Question: Write a descriptive caption for this figure.
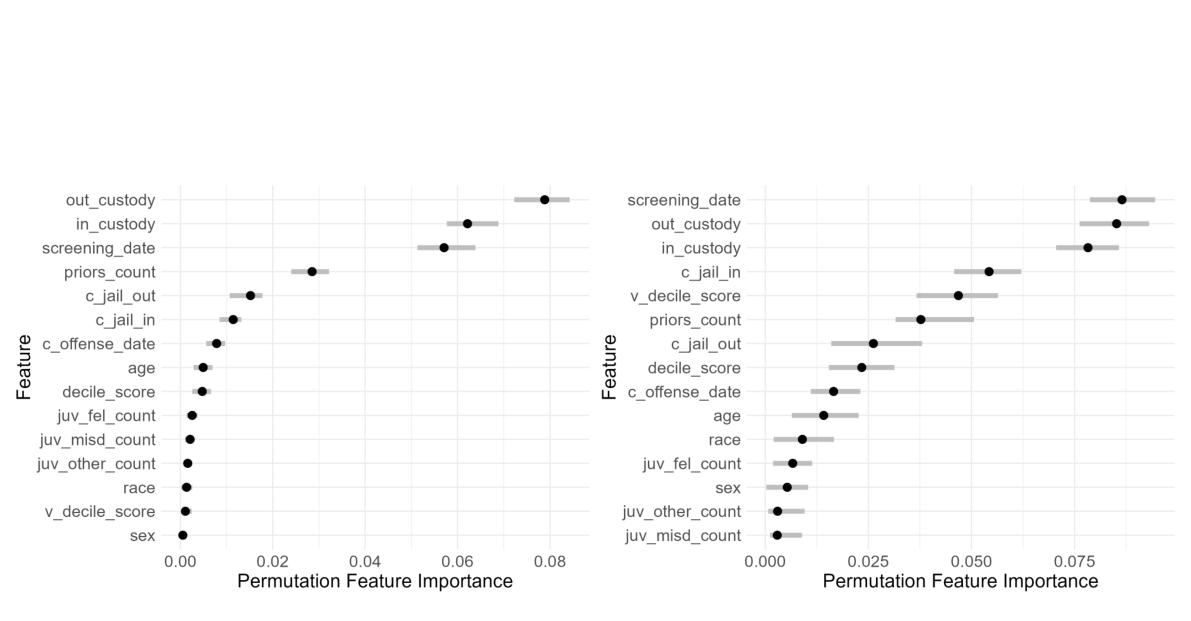
Answer: Permutation Feature Importance for f(x) before Attack (Left) and a(x) after Attack (Right), COMPAS Data. The grey lines represent the range from the 10th to the 90th percentile of PFI estimates across fifty runs, with median values indicated by black dots.